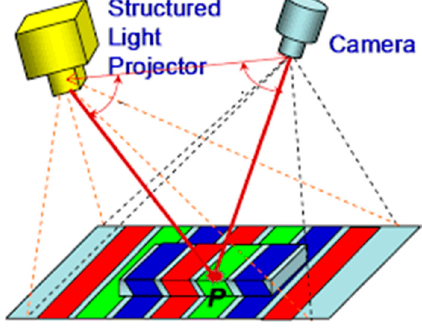
Figure 3. The principle of structured light.